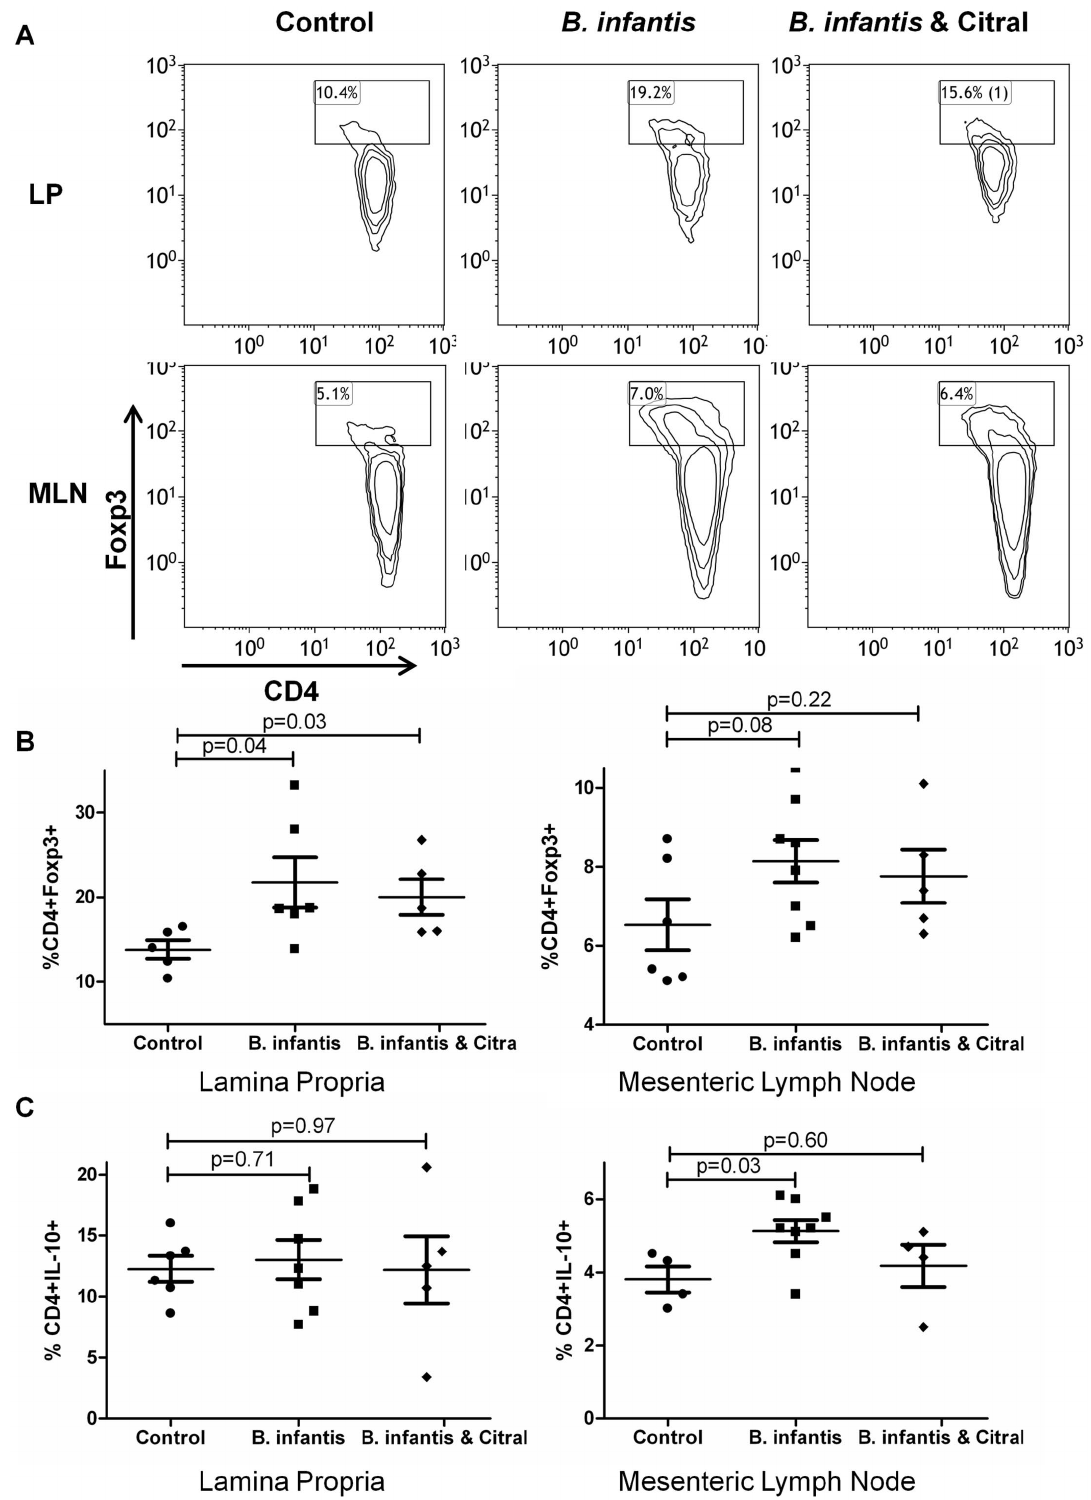
Figure 4. B.infantis induction of Foxp3 + lymphocytes is not RALDH-dependent. ( a ) Representative flow cytometric dot-plots are illustrated for CD4 and Foxp3 populations within MLN and LP. ( b ) The increase in CD4 + Foxp3 + T lymphocytes following B. infantis feeding in the LP (n=6) is not reversed by citral treatment (n=5). ( c ) CD4 + IL-10 + T lymphocytes increased within MLN (n=8), but not the LP (n=7). LP statistical significance was estimated using the non-parametric Mann-Whitney test, while MLN statistics were determined using the parametric unpaired student t-test.